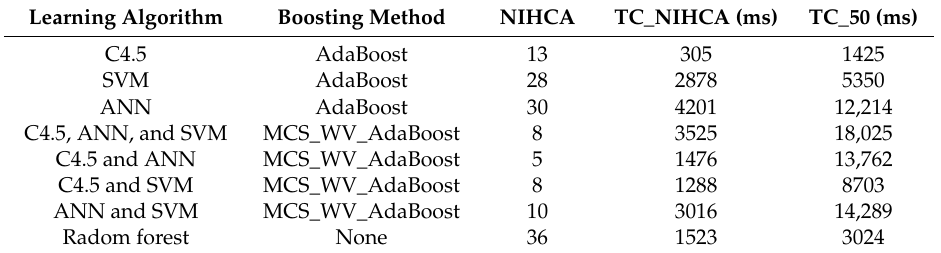
Table 8. Computation time costs of different MCS_WV_AdaBoosts and the random forest. Learning